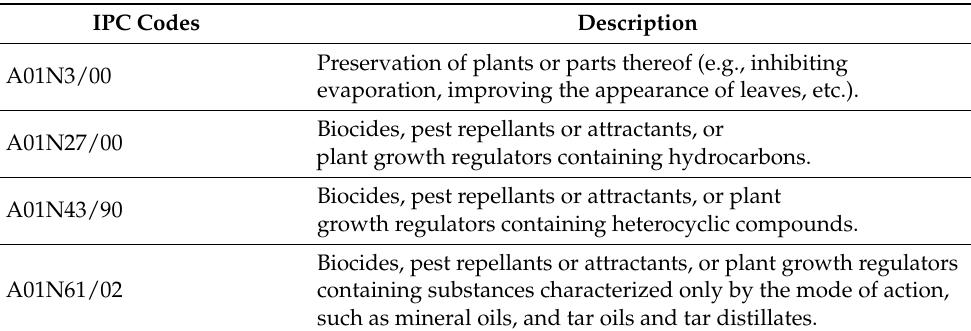
Table 1. Classifications of the five patent families of this study